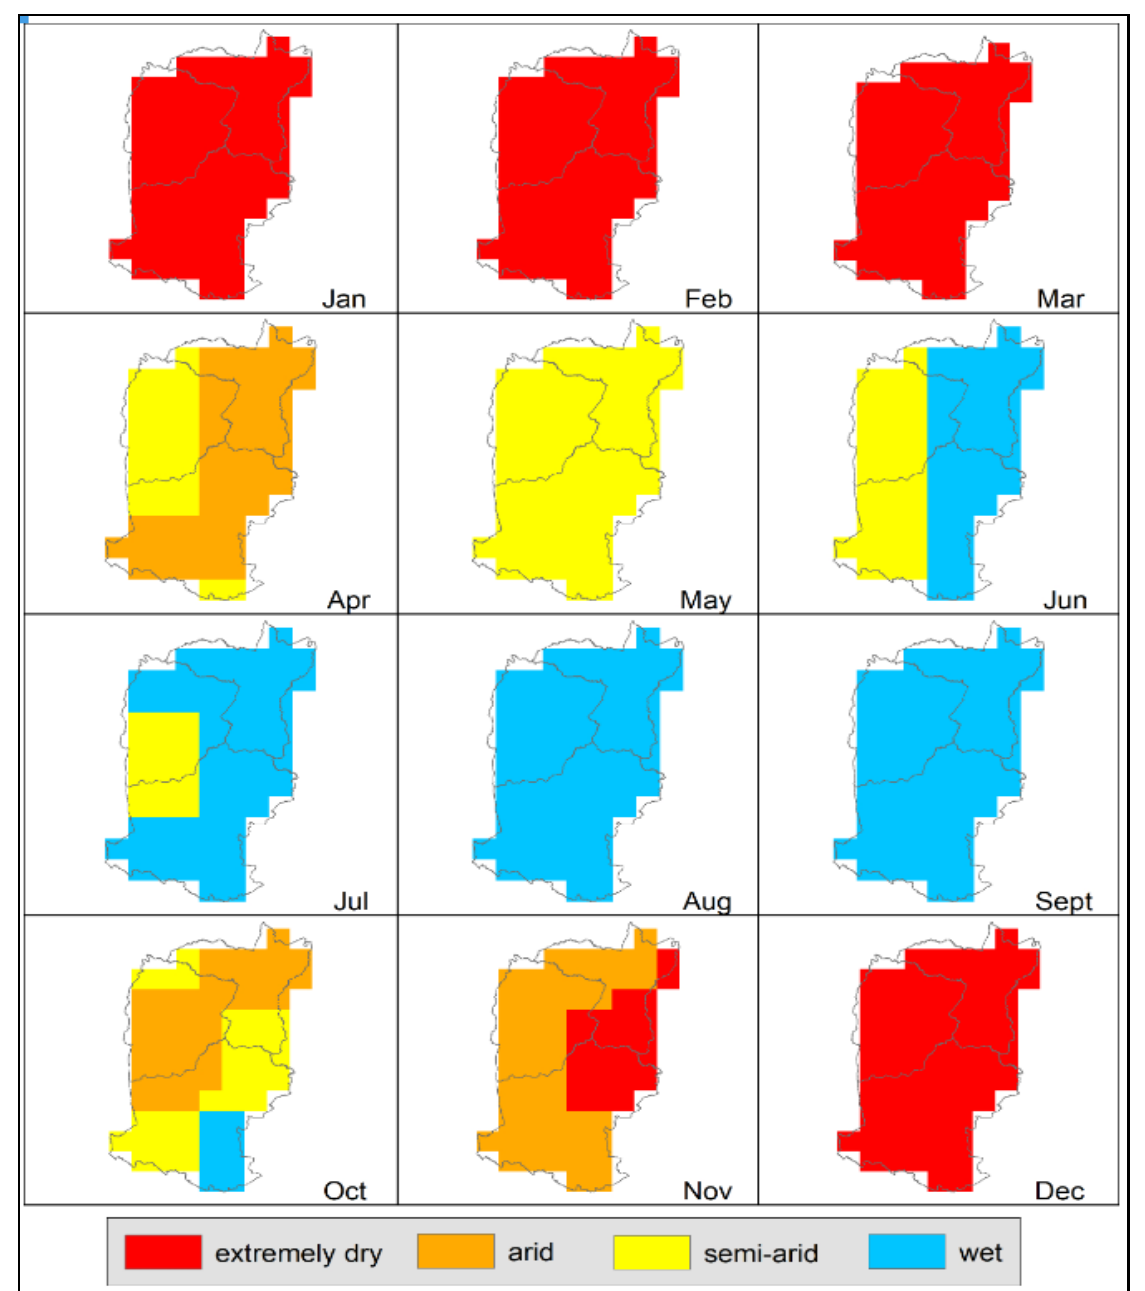
Figure 9. Thornthwaite aridity index map for 2014.